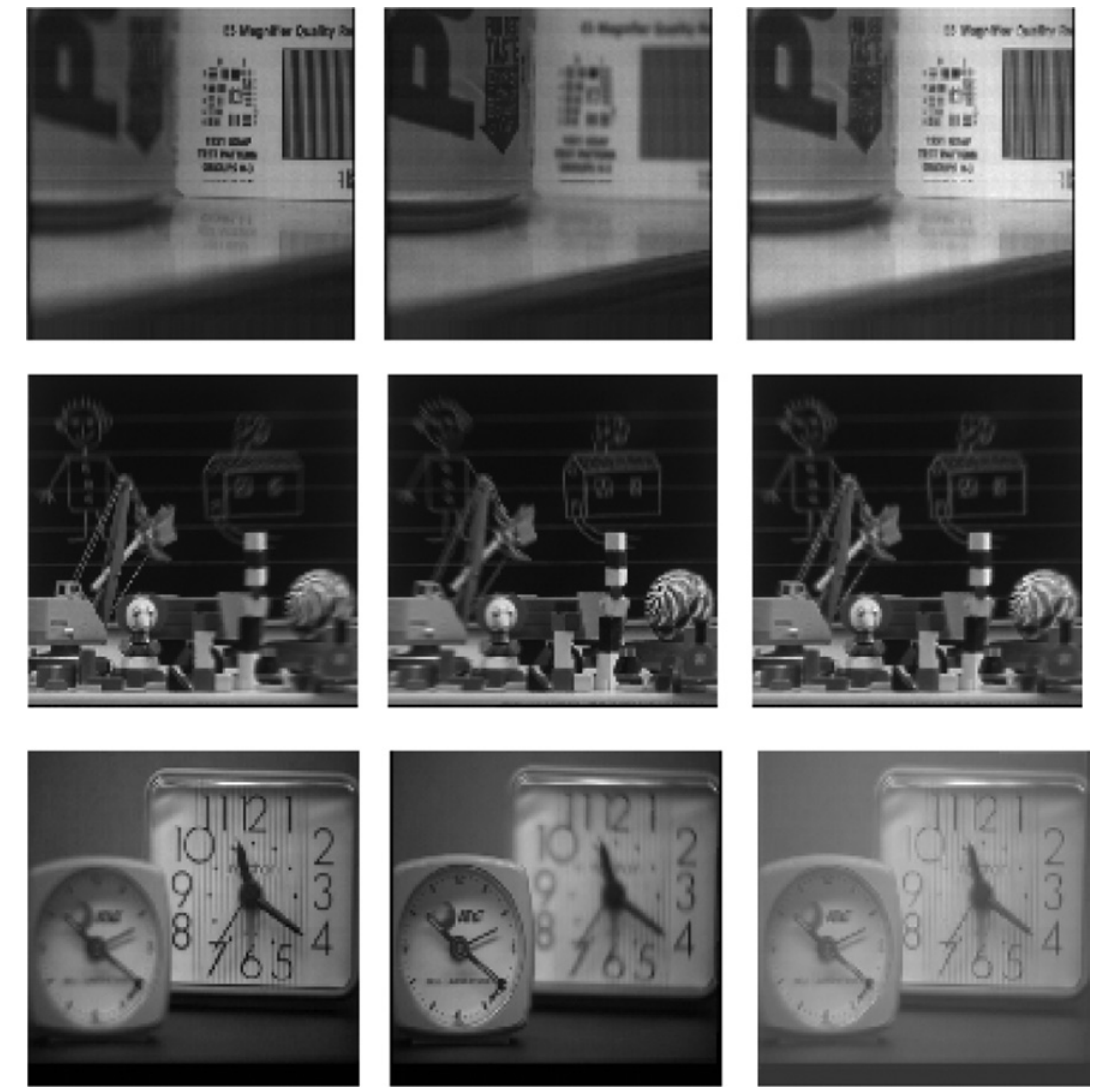
Figure 6: Absolute Maximum Fusion Rules of Low-Frequency Coefficient and High-Frequency